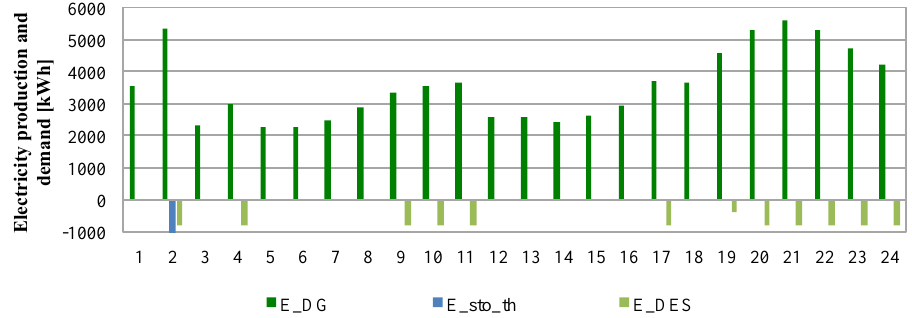
Figure 17. Optimal daily schedule of diesel generators and desalination units in January (average load month) in the TO-BE scenario 2. In this figure E_DG is the variable E DG , E_sto_th is the variable E sto,th and E_DES is the variable E DES.